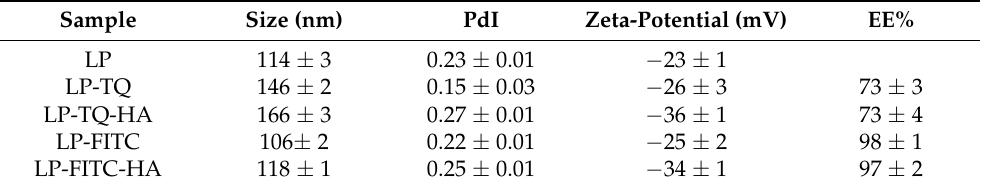
Table 3. Physical and chemical characterization of empty liposomes (LP), TQ- and fluorescein isothiocyanate (FITC)-loaded liposomes (LP-TQ and LP-FITC), and HA-coated liposomes (LP-TQ- HA and LP-FITC-HA) (Mean ± SD, n = 3).